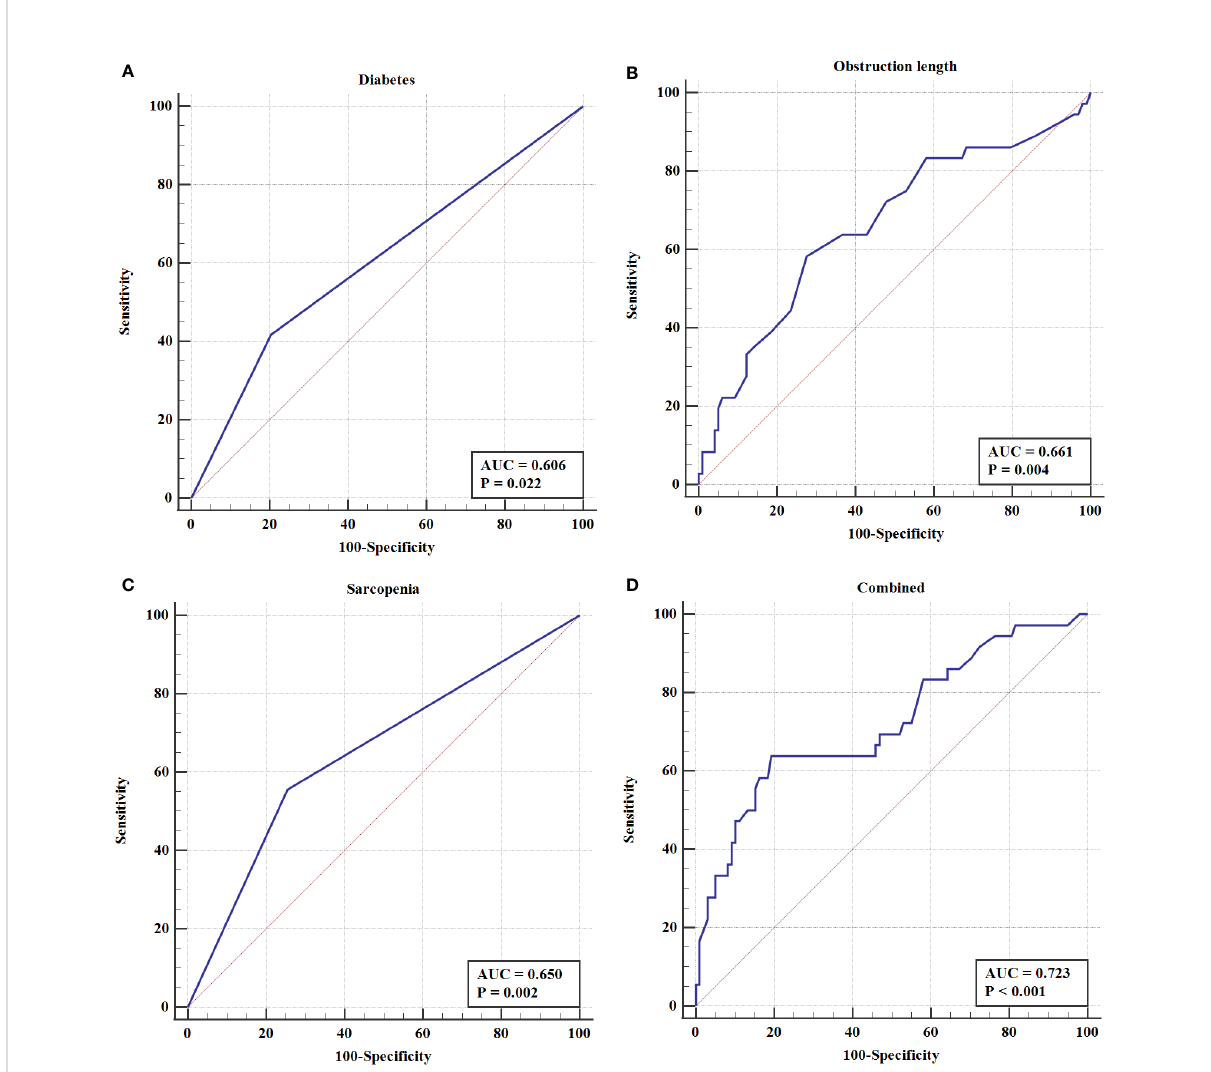
FIGURE 5 The ROC curve of (A) Diabetes (B) Obstruction length (C) Sarcopenia (D) Combined index in EBI after PTBS placement in patients with inoperable